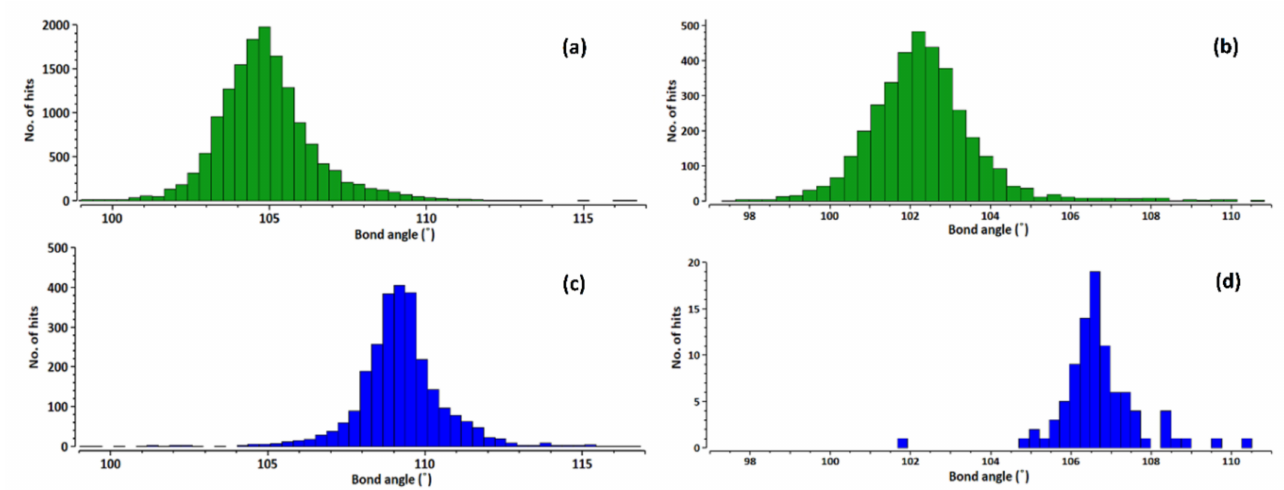
Chart 2. Histogram of CNC angles ( θ 1 / θ 2 ) in neutral (green) imidazoles ( a ) and 1,2,4-triazoles ( b ) and in protonated (blue) imidazoles ( c ) and 1,2,4-triazoles ( d